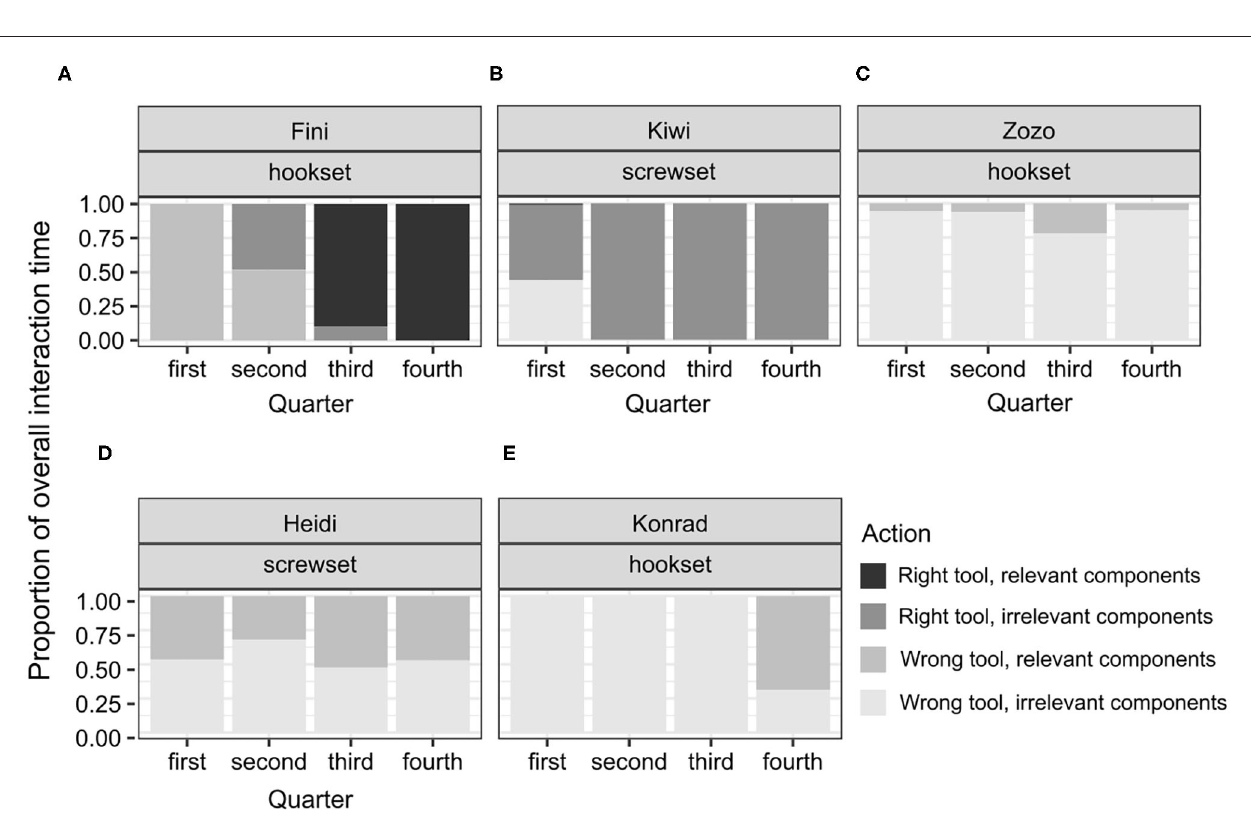
Frontiers in Psychology |